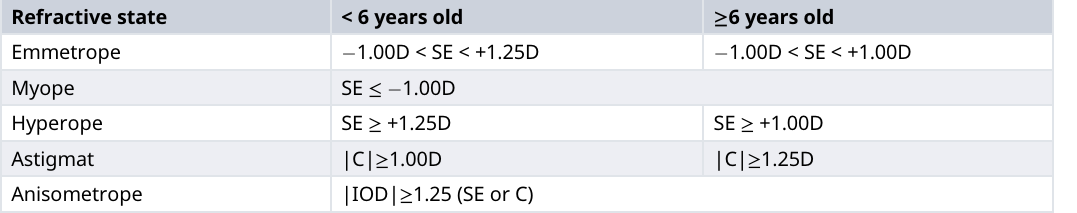
Table 2. Classification criteria for refractive state.